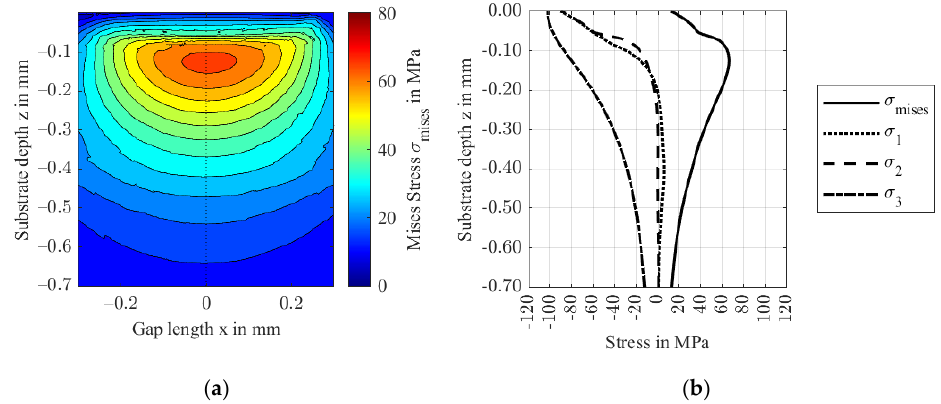
Figure 19. Pressure and film thickness profiles along the gap length x ( a ) and gap width y ( b ) and film thickness contour in the xy-plane including minimum ( c ) for distributed fiber content and orientation acc. to Figure 18.